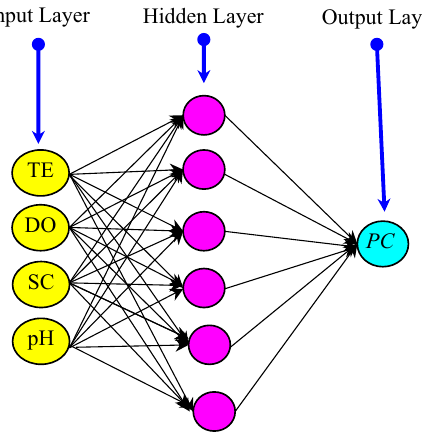
Fig. 1 Architecture of FFNN with four input variables used for mod- eling PC